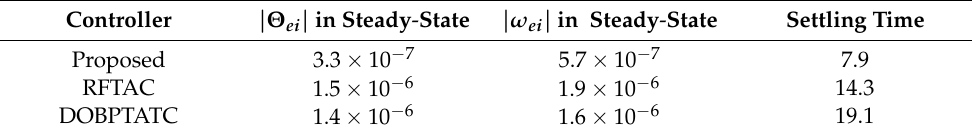
Table 1. Performance comparison with different controllers.